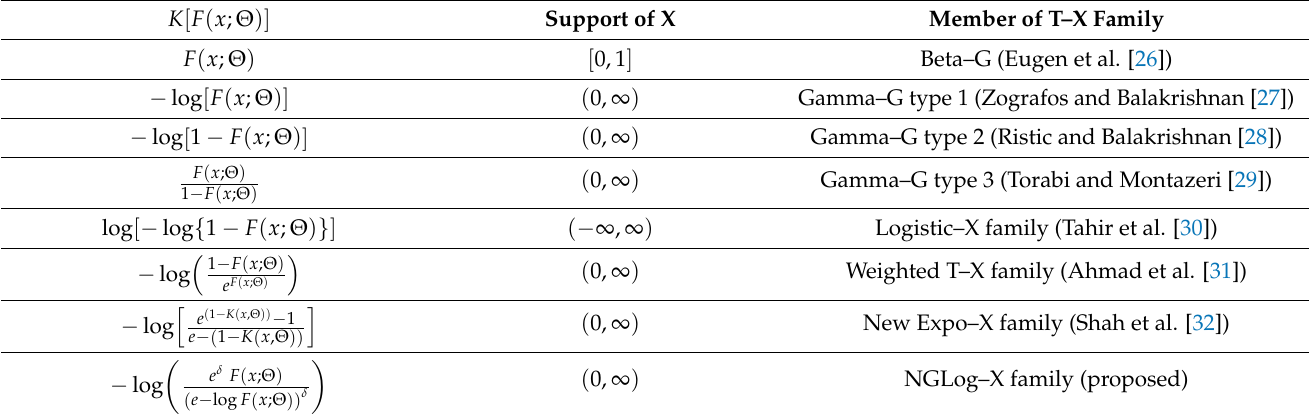
Table 1. Different K [ F ( x ; Θ )] functions for some members of the T–X